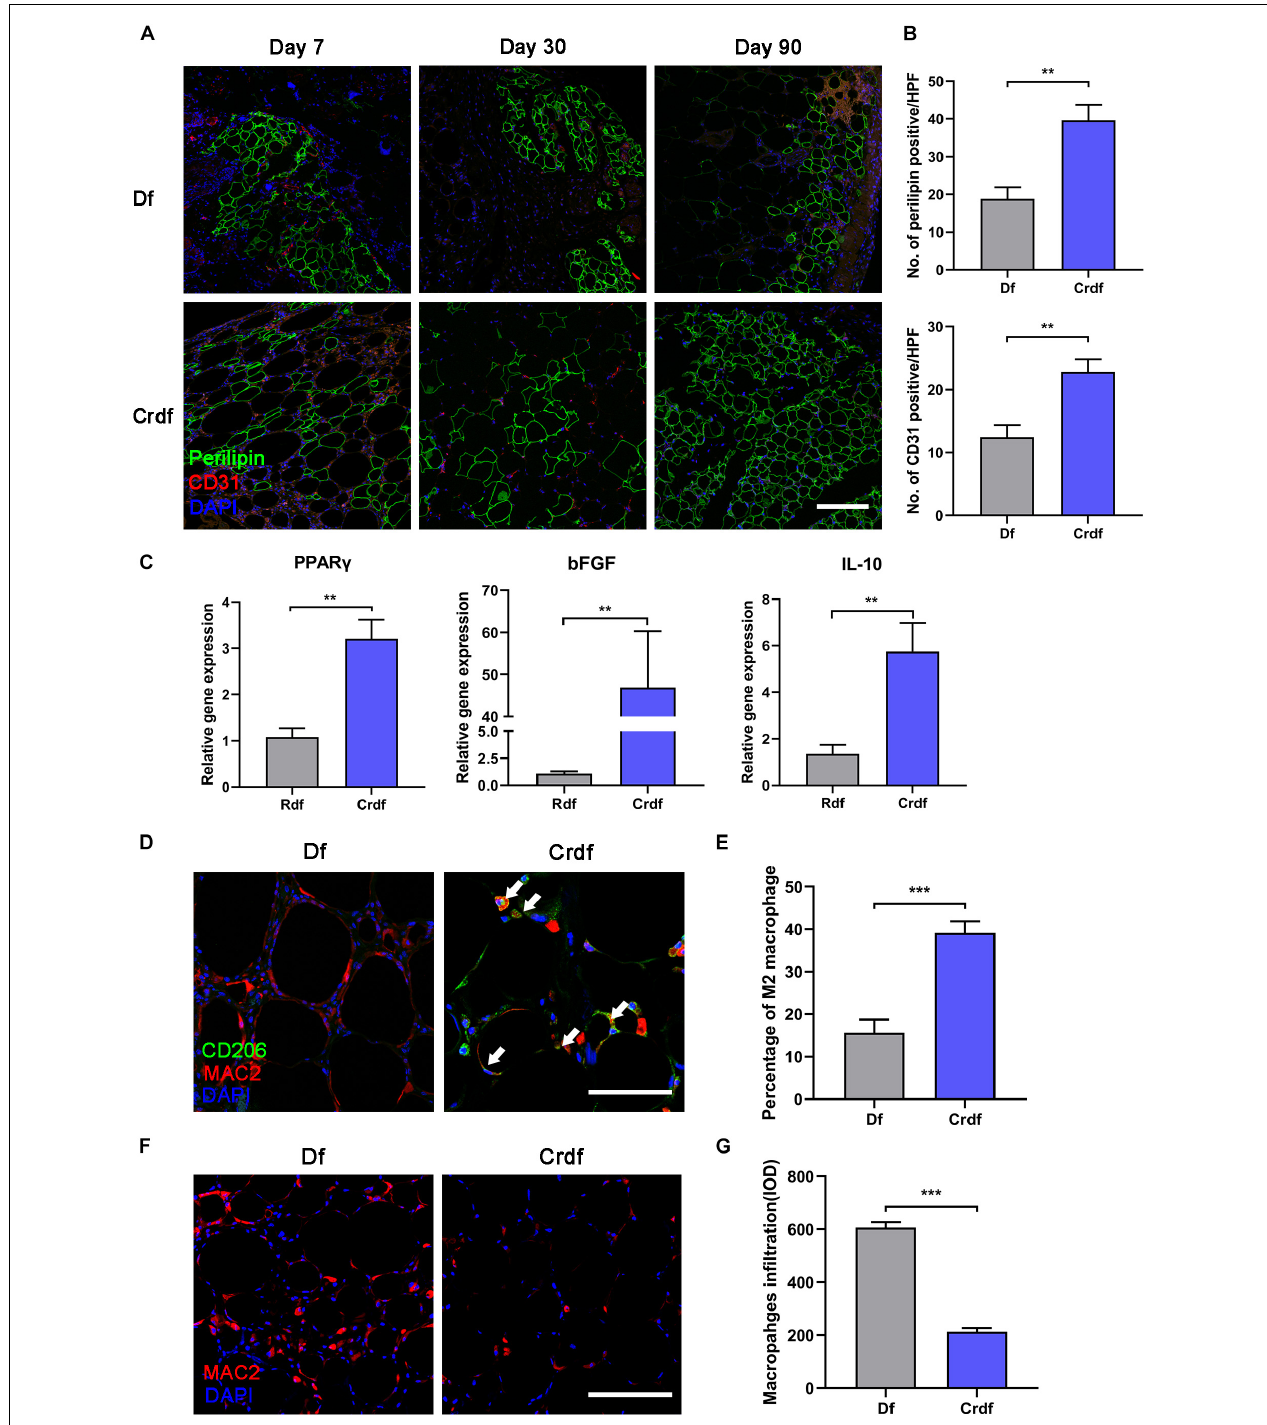
FIGURE 4 | ASC supplementation rescue poor adipogenesis and reverse M1 inflammation in Df. (A) Representative immunofluorescence staining of perilipin (green) and CD31 (red) in Df and Crdf on post-operative day 7, 30, and 90. (B) Quantification of perilipin-positive area and CD31-positive area in grafts on post-operative day 30 per high power field. (** p < 0.01). (C) Relative transcription of PPAR γ , bFGF, and IL-10 (** p < 0.01). (D) Representative immunofluorescence staining of CD206 (green) and Mac2 (red) in Df and Crdf on post-operative day 7. (E) Quantification of percentage of CD206 + /Mac2 + M2 macrophage in Mac2 + macrophage in grafts on post-operative day 7 per high power field (*** p < 0.001). (F) Representative immunofluorescence staining of Mac2 (red) in Df and Crdf on post-operative day 90. (G) Quantification of Mac2 + macrophage infiltration in grafts on post-operative day 90 (*** p < 0.001). n = 3 independent experiments with 5 samples each group. Scale bar = 100 µ